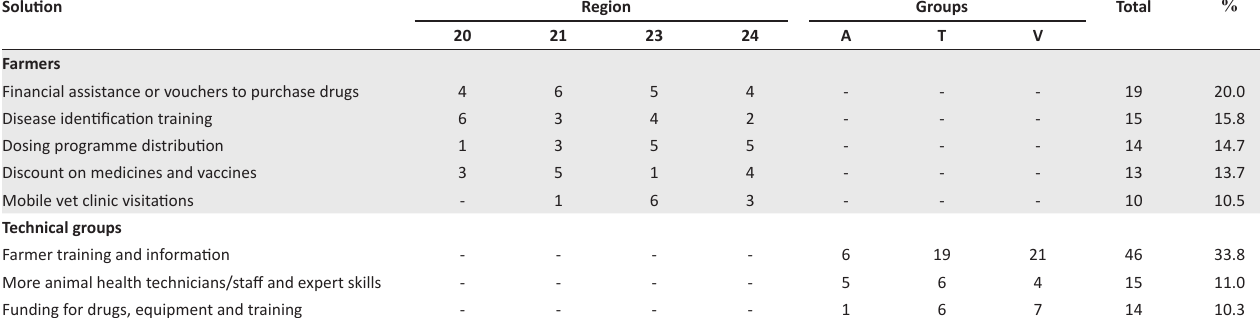
TABLE 10: Solutions that received support from more than 10 % of respondents. Solution